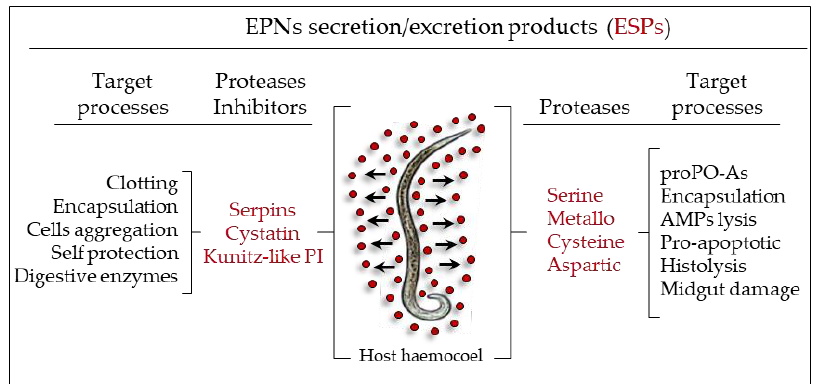
Figure 18. Summary of the effects of secretion/excretion products (ESPs) of S. carpocapsae throughout infection.